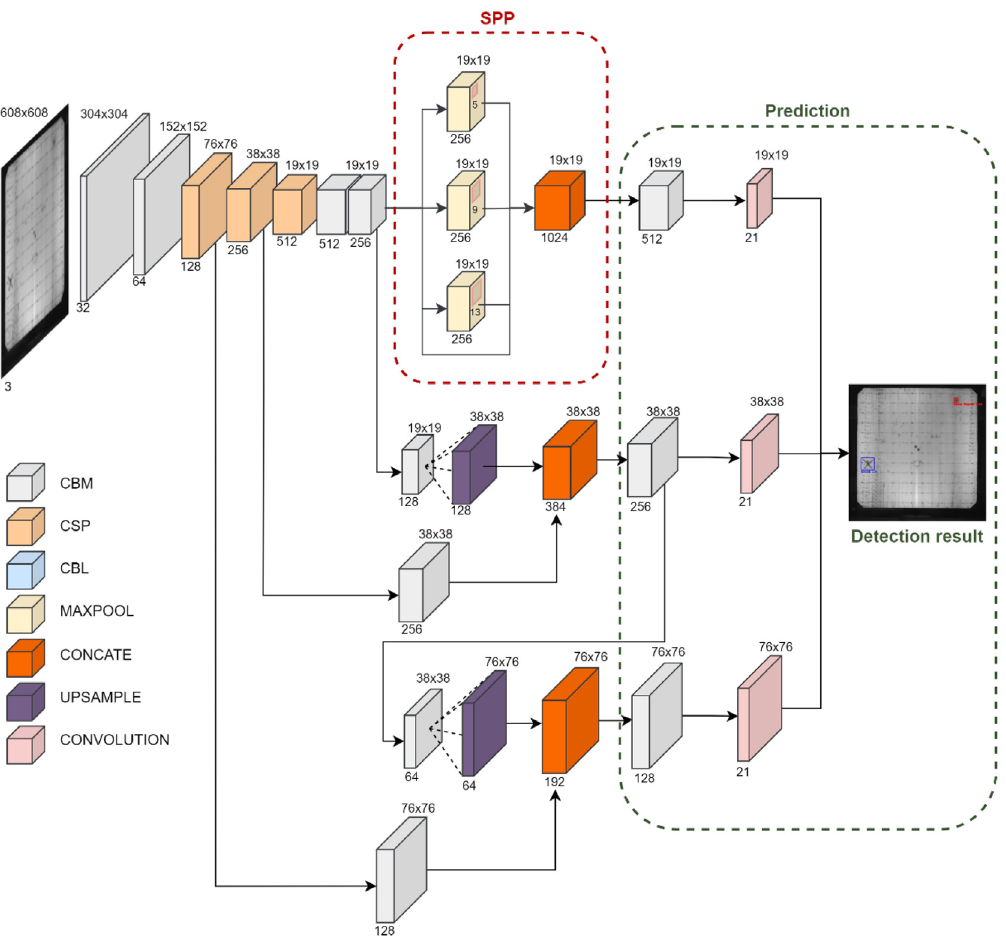
Fig. 9. Modi fi ed multi-class Tiny-YOLOv4 with SPP